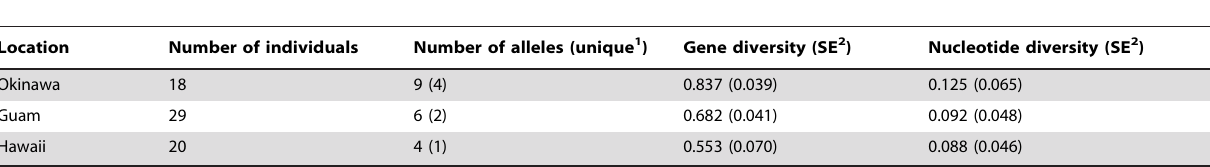
Table 1. Sample size, numbers of alleles and diversity statistics of Conus ebraeus conotoxin locus E1 .